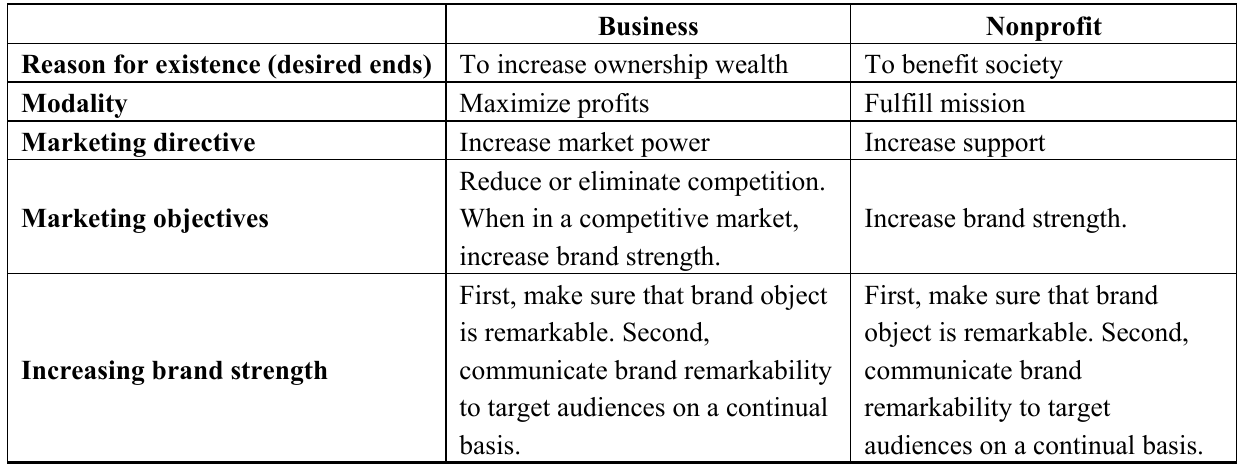
Table 1. Comparison of business to nonprofit